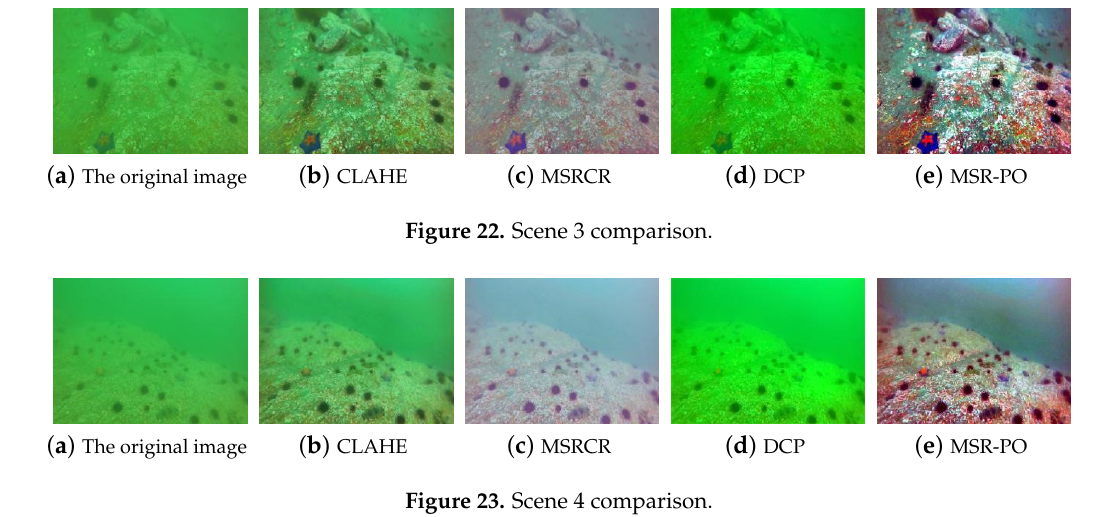
Figure 23. Scene 4 comparison.